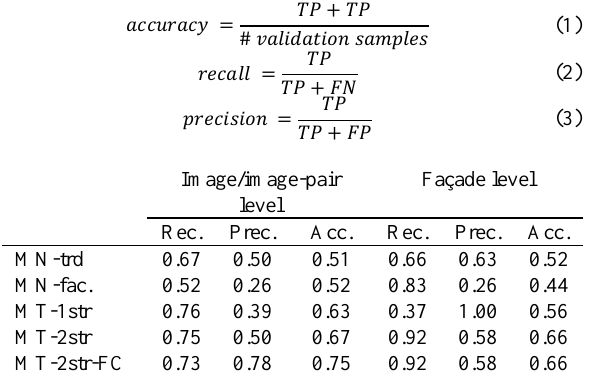
Table 2. Precision, recall and accuracy (0-1) for the defined models. This is given at an image or image pair level and on a facade level.